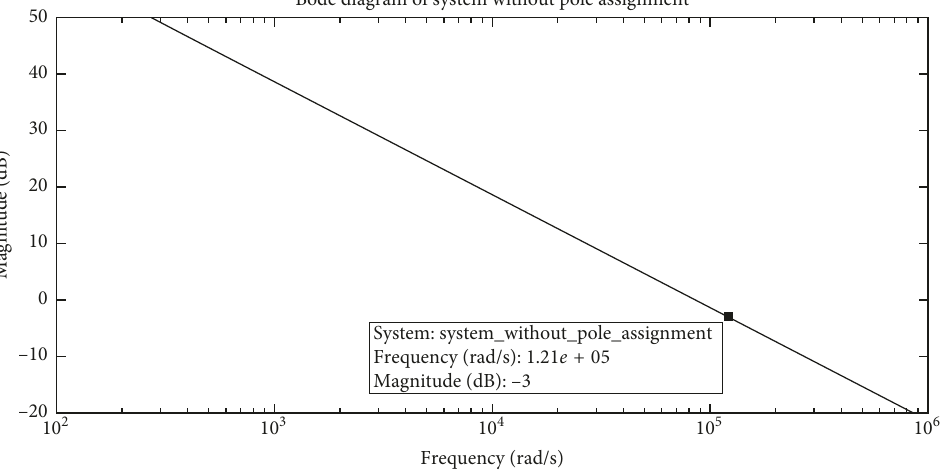
Figure 5: The closed-loop frequency-domain bode diagram of the wave compensation